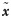
Screening interval required to reach elimination within five years, for different levels of the case detection fraction (p ⋅ s) and different current long term prevalence levels (x˜).